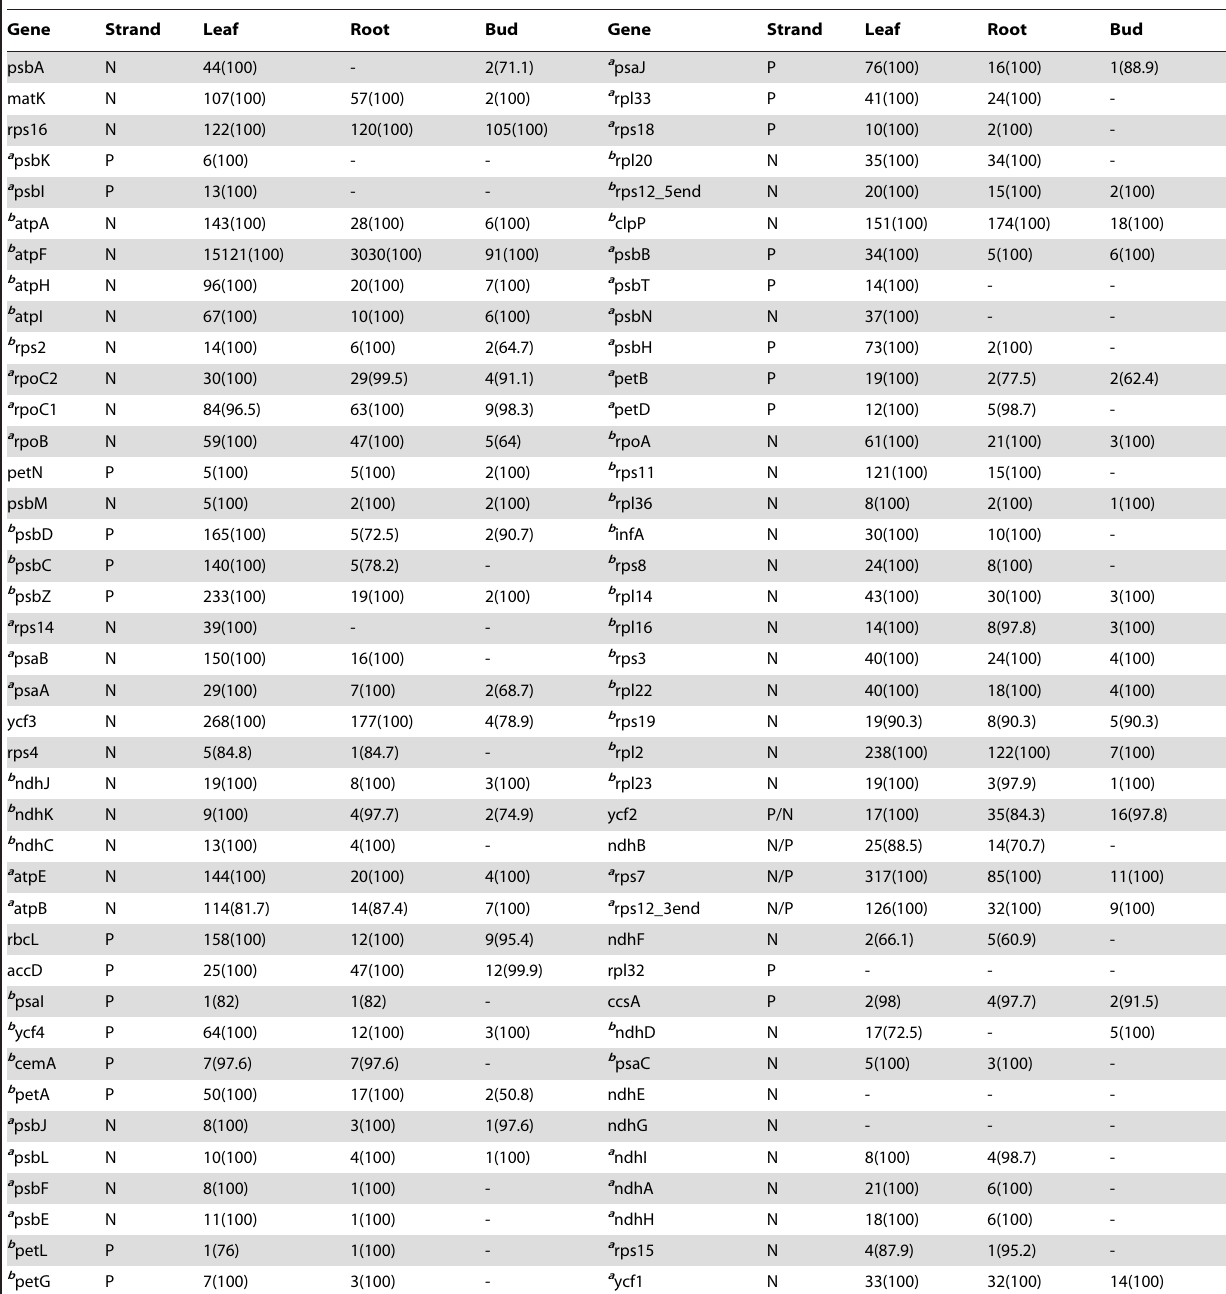
Table 5. Expression information of date palm cp genome in leaf, root, and bud.